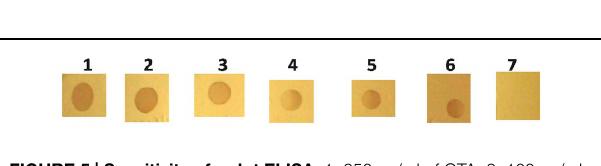
FIGURE 5 | Sensitivity of s-dot ELISA. 1: 250 ng/ml of OTA; 2: 100 ng/ml of OTA; 3: 50 ng/ml of OTA; 4: 25 ng/ml of OTA; 5: 10 ng/ml of OTA; 6: 5 ng/ml of OTA; 7: 1